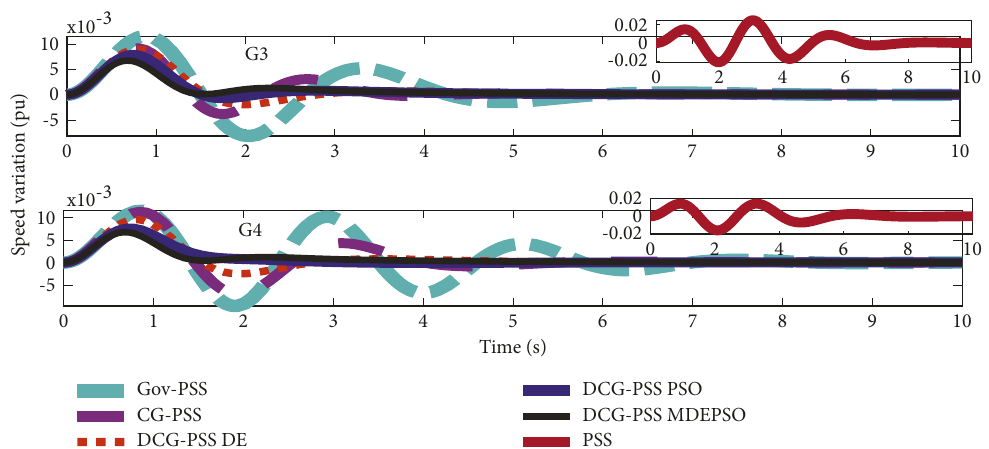
Figure 13: Angular frequency variation for G